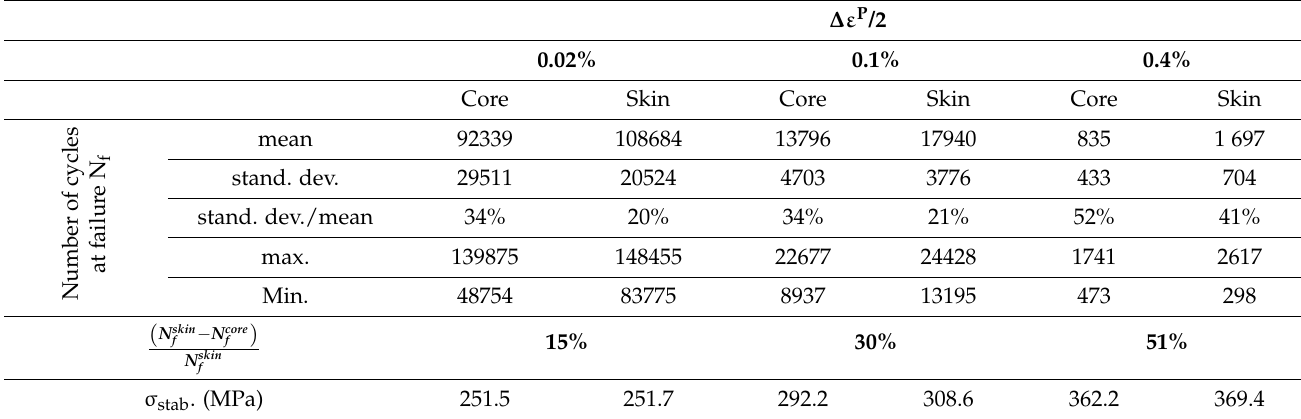
Table 9. Detailed results from low cycle fatigue